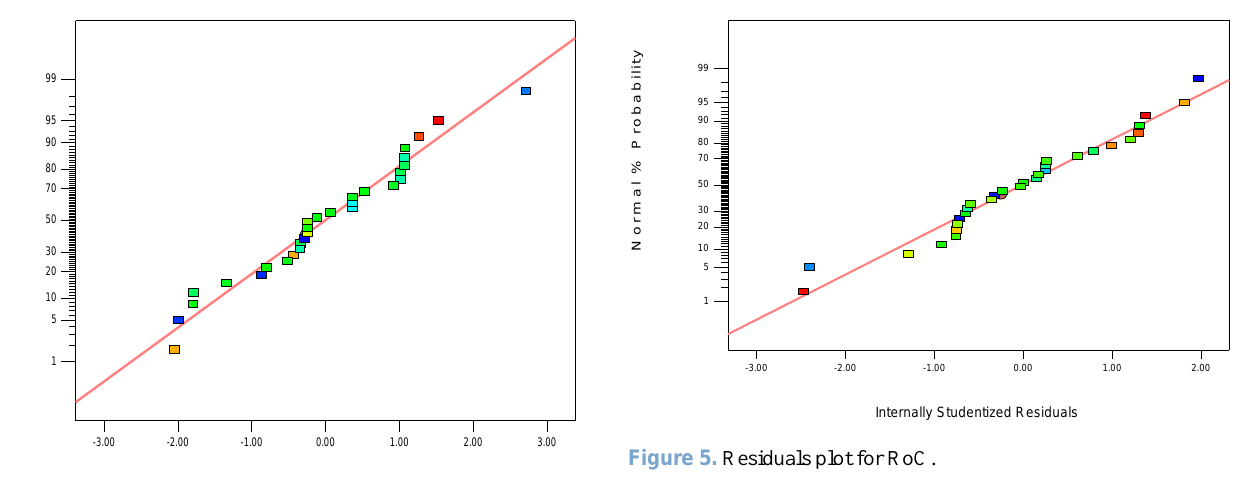
Figure 4 Residuals plot for SR